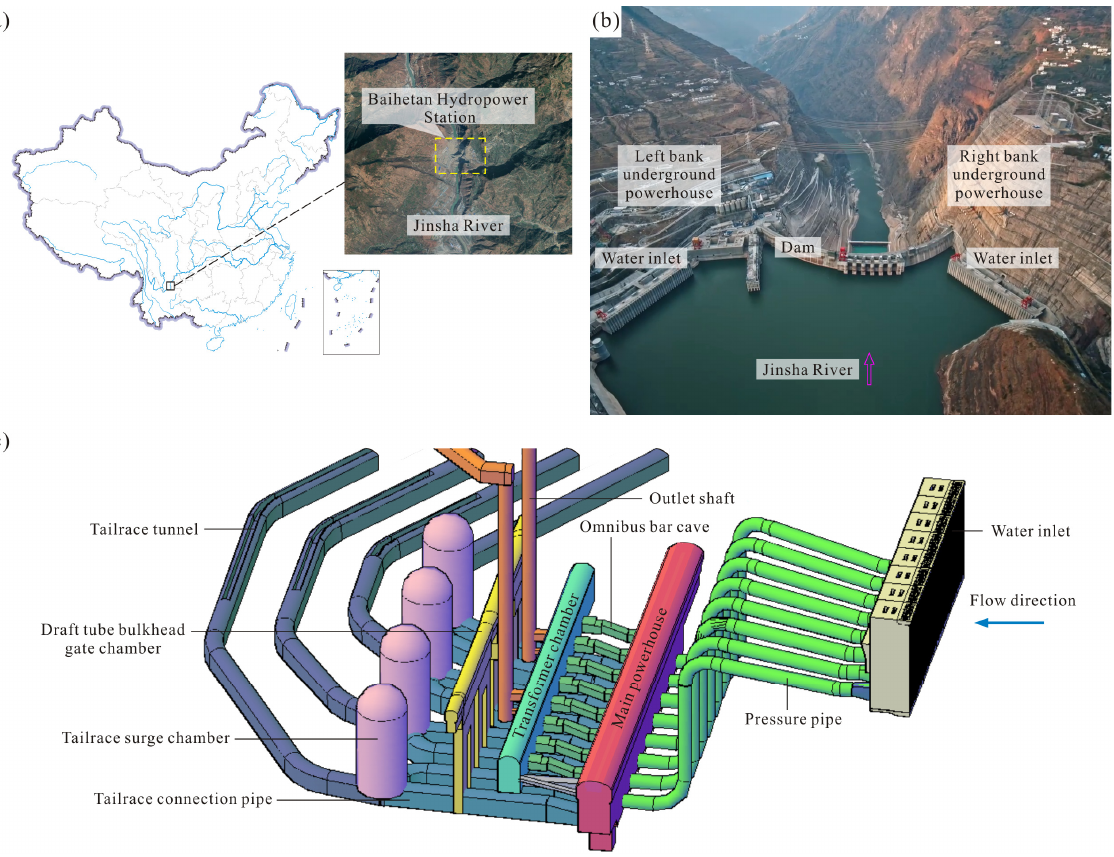
Figure 2. The Baihetan hydropower station and underground powerhouse: ( a ) the location, ( b ) an aerial view at the dam site and ( c ) a three-dimensional layout of the left bank underground powerhouse.